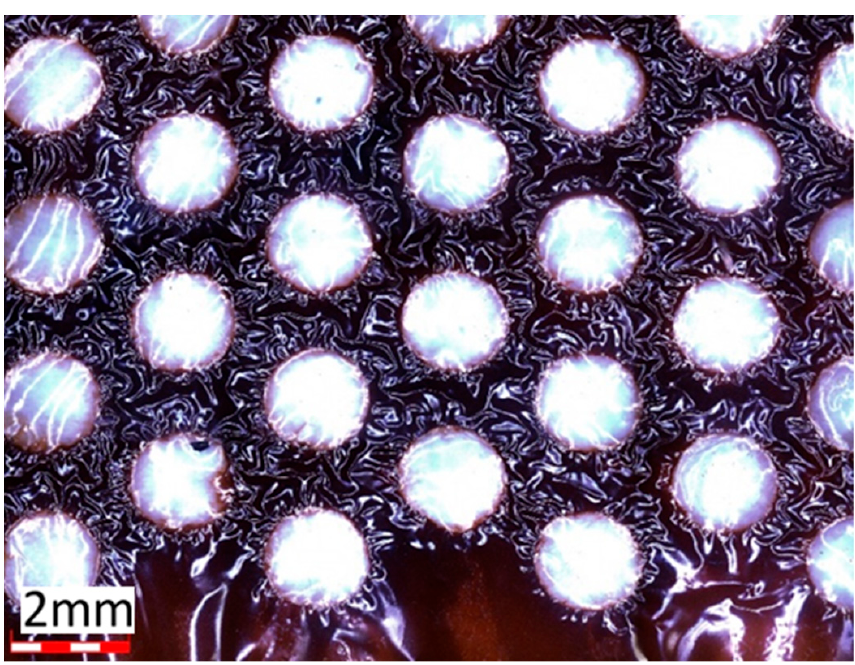
Figure 3. Optical microscope image of crosslinked LLDPE film with transparent non-stabilized (white) zones.